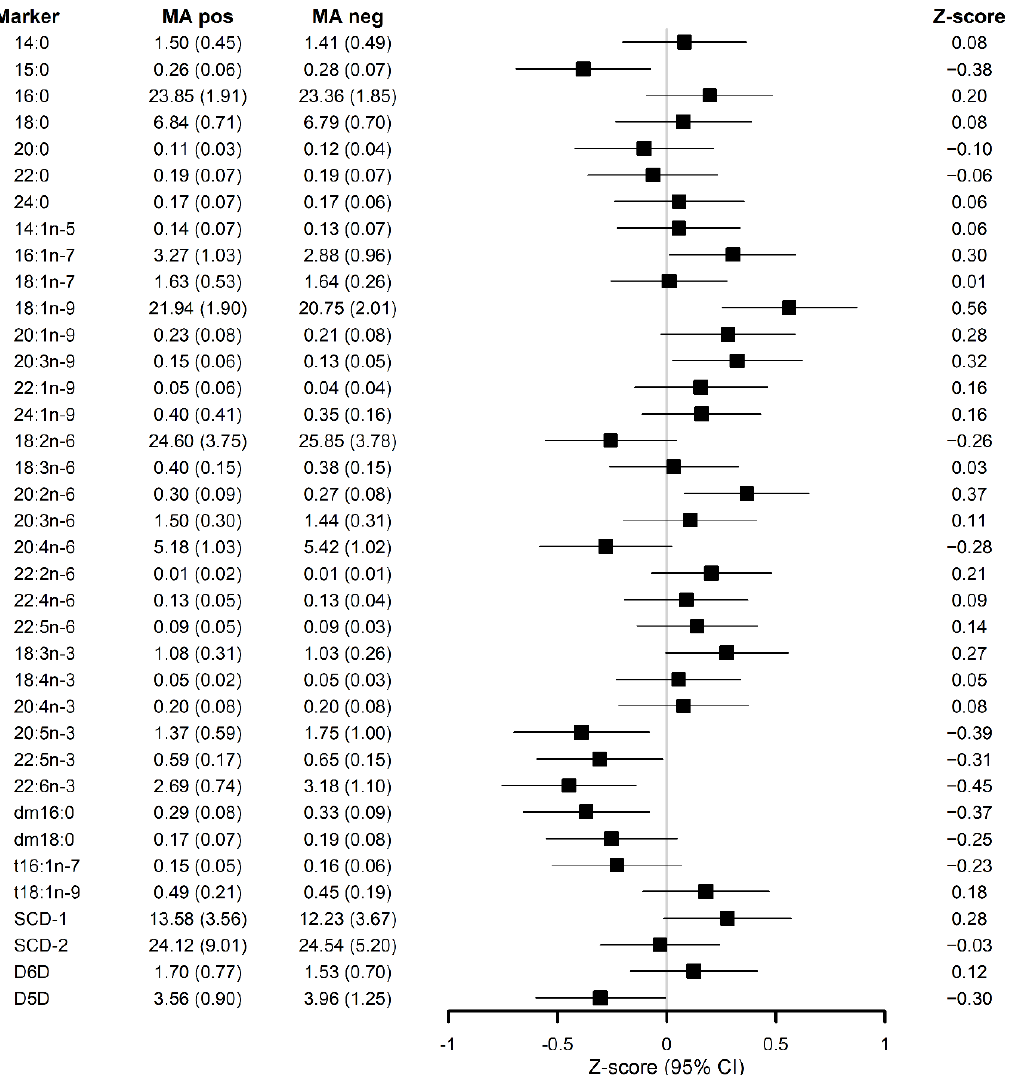
Figure 1. Z-scores for serum lipid metabolite markers and their standard deviations (SD) in the forest plot describing the association of each serum lipid metabolite markers with the occurrence of microaneurysms after applying full-adjusted linear mixed effect (LME) model for repeated measurements adjusted for study group, BMI, HbA1c, age, sex and fasting serum triglycerides. dm: plasmalogen; t: trans; SCD-1: Stearoyl-coenzyme A desaturase 1; SCD-2: Stearoyl-coenzyme A desaturase 2; D5D: delta 5 desaturase enzyme; D6D: delta 5 desaturase enzyme.